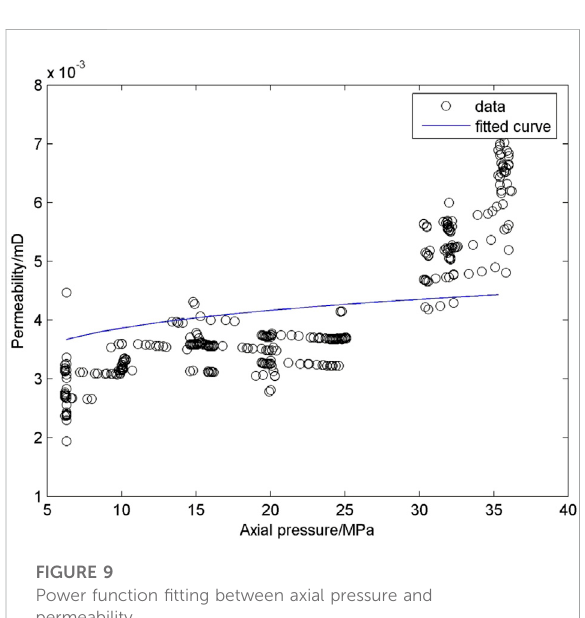
FIGURE 9 Power function fi tting between axial pressure and permeability.